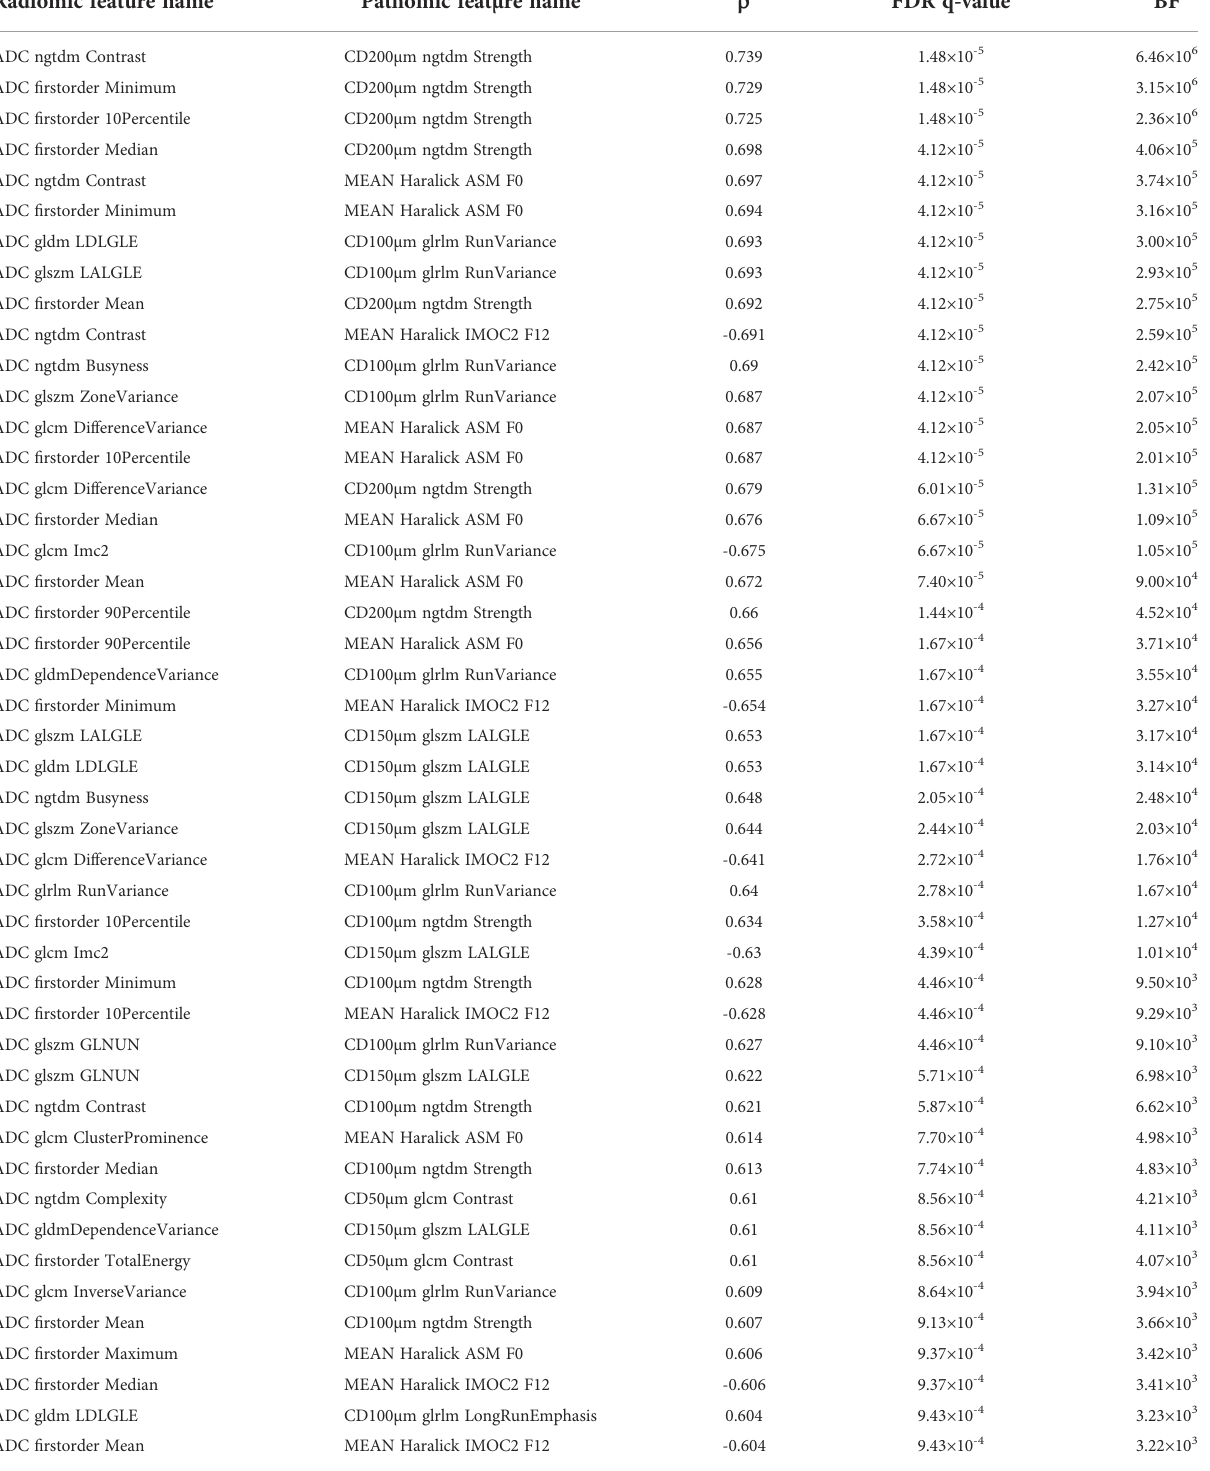
TABLE 2 Summary of the highest-correlated ( r >0.6) radiomic-pathomic features, with radiomic features extracted from